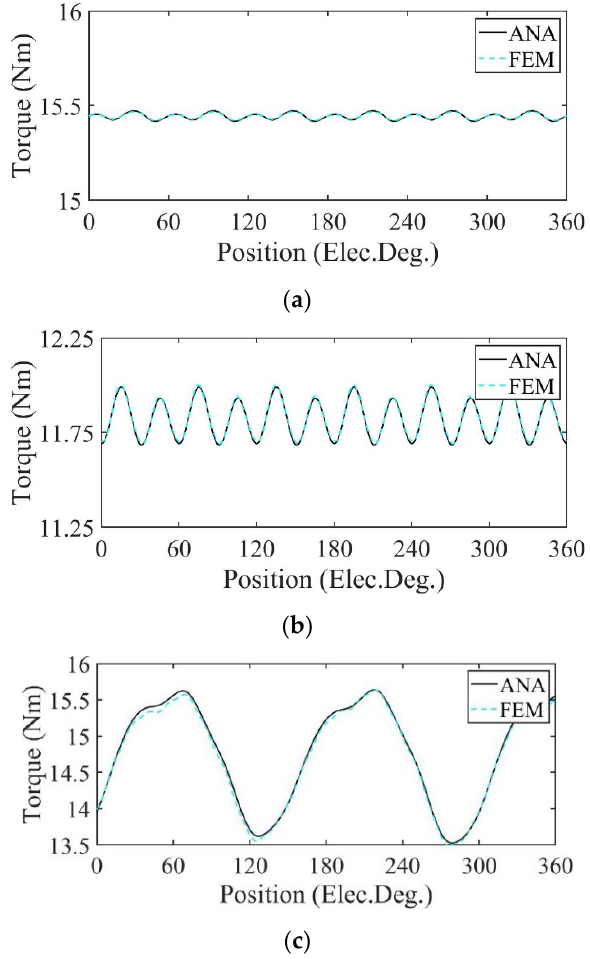
Figure 23. Output torque comparison. ( a ) Healthy; ( b ) uniform demagnetization; ( c ) partial demag- netization.